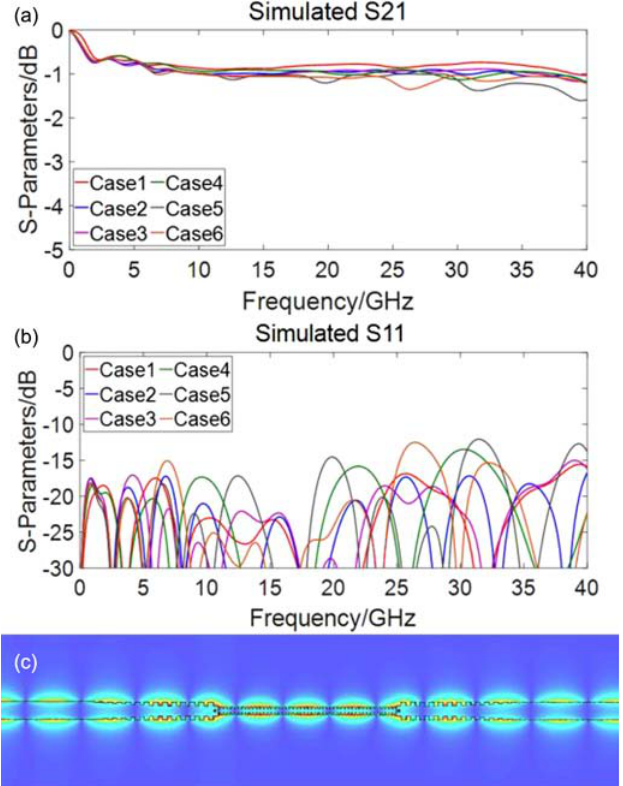
Fig. 4. (a) The simulated S21 for the 6 cases of the SSPP TLs. (b) The simulated S11 for the 6 cases of the SSPP TLs. (c) The simulated electric fi eld distribution of the multi-layer SSPP TL (Case 2 at 20